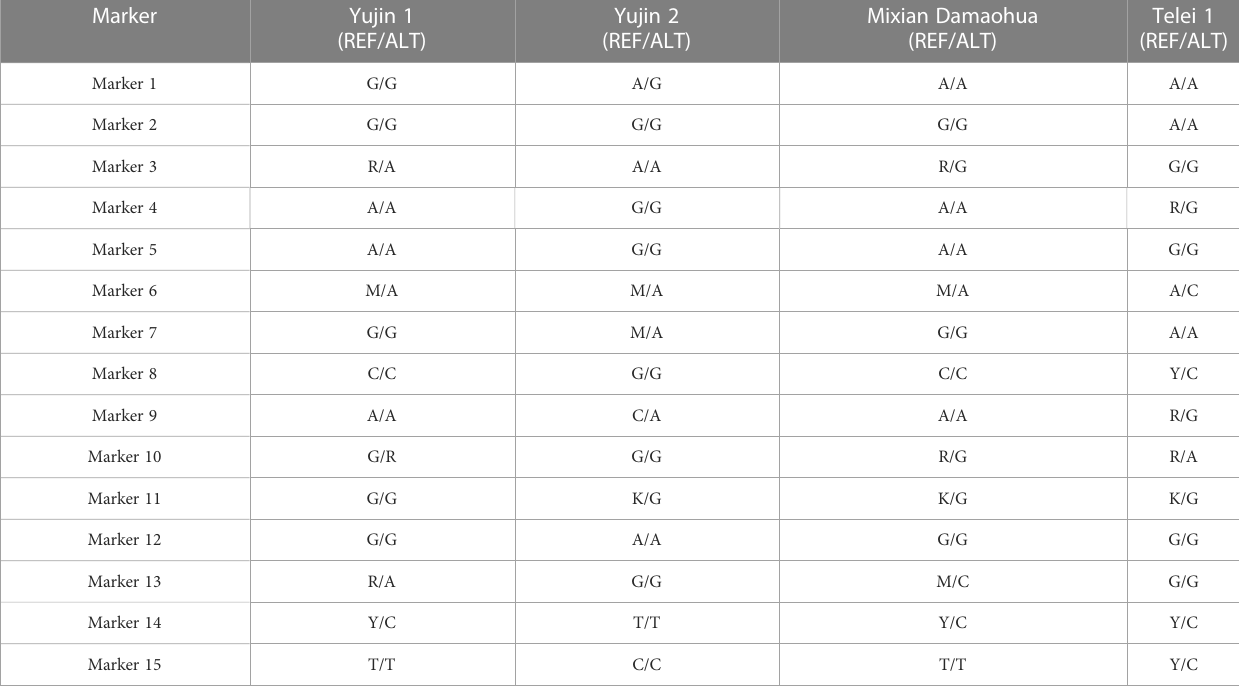
TABLE 5 Veri fi cation results of 15 single nucleotide polymorphism (SNP) sites. Marker